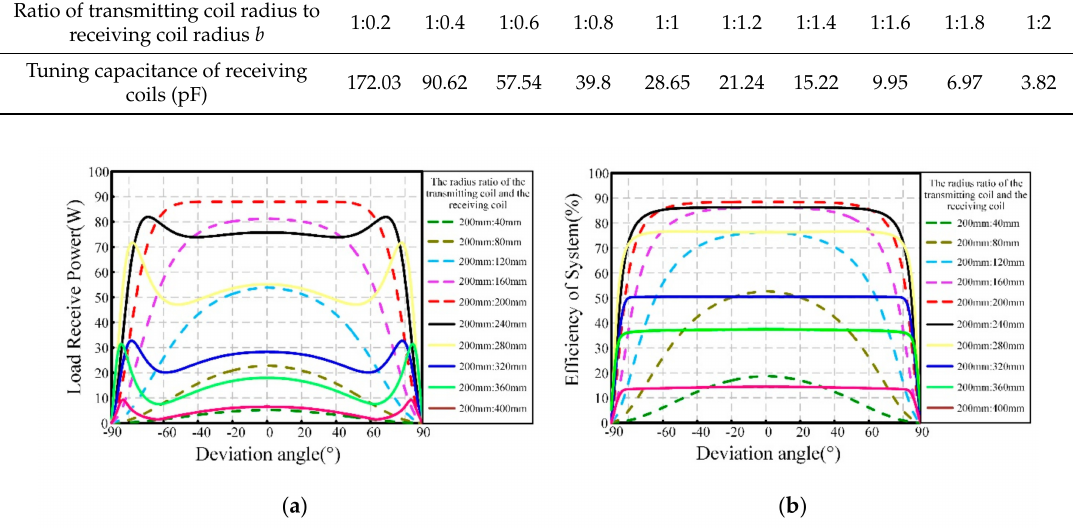
Figure 10. Simulation results at di ff erent radius ratios. ( a ) Load receive power vs. deviation angle. ( b ) E ffi ciency of system vs. deviation